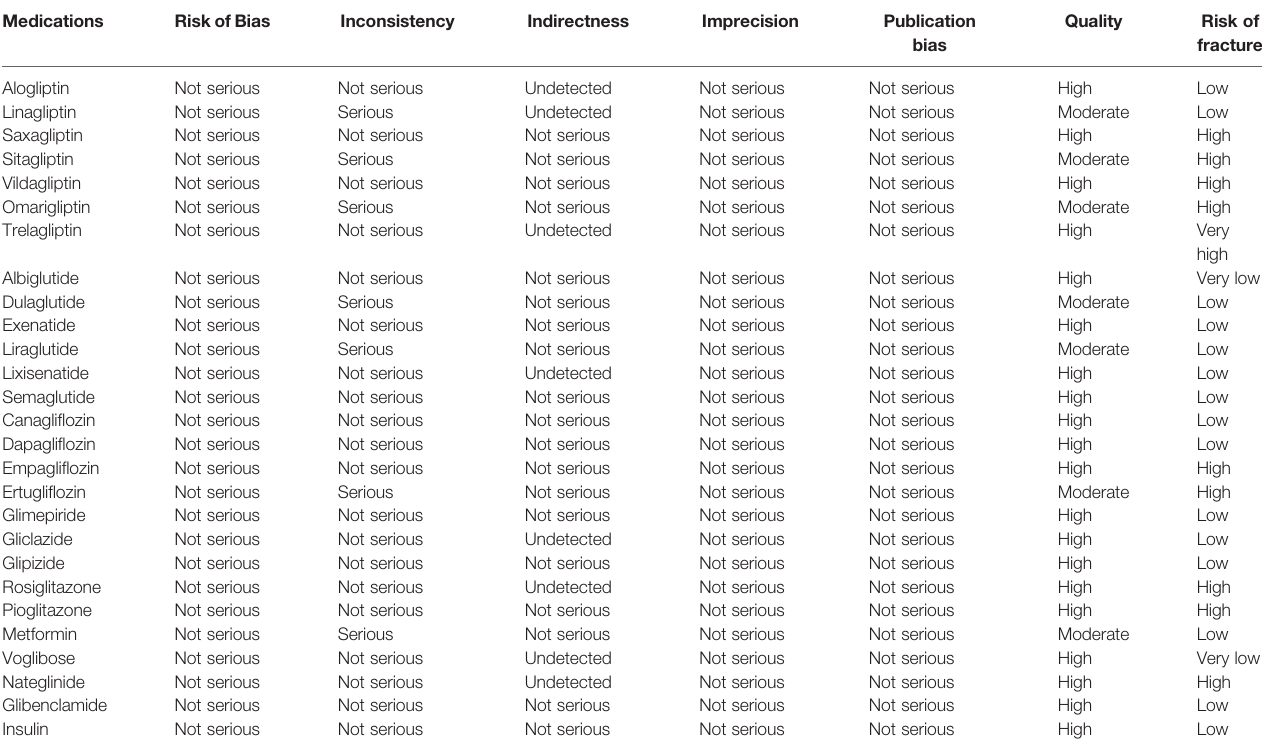
TABLE 2 | GRADE of quality evidence for glucose-lowering medications on fracture outcomes. Medications Riskof